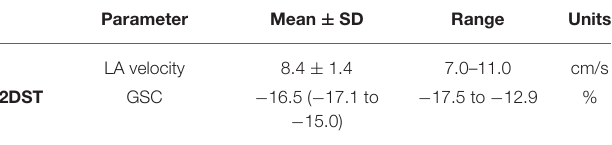
TABLE 2 | Echocardiographic measurements ( n = 7). GSC data are presented as median (IQR1-IQR3). due to non-normal